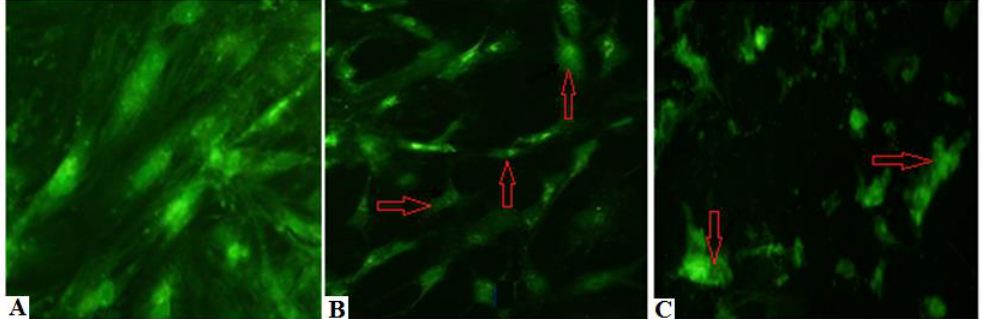
Fig. 1. Microscopic images of differentiated cells stained with Hoechst: A) control group; B) cells treated with 1 mM of DEA; C) cells treated with 4 mM of DEA; Arrows show nuclear enlargement in the 4 mM treated group (200 magnifications).